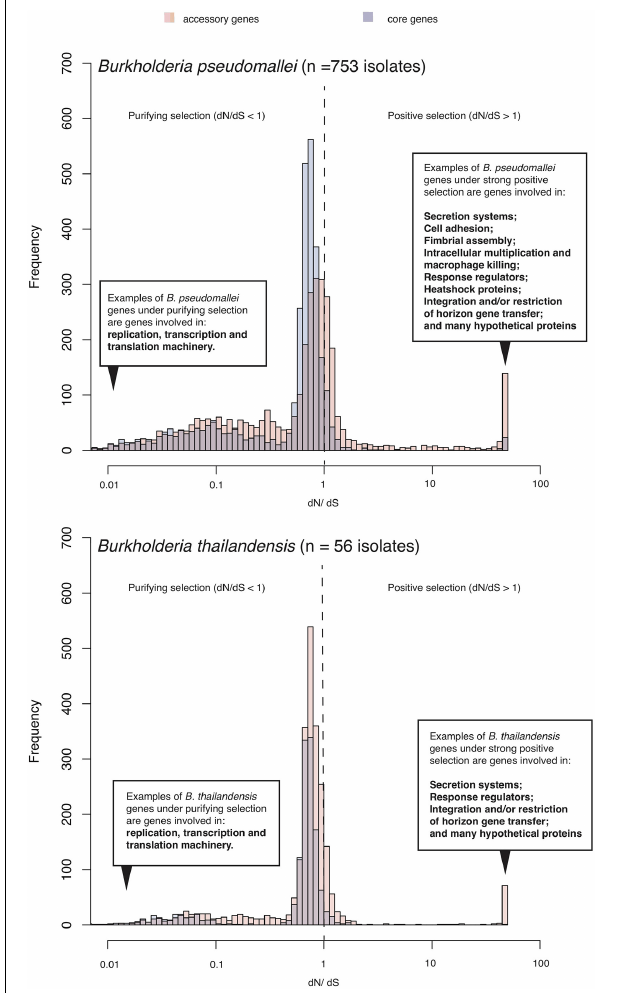
FIGURE 1 | Selection pressure acting on B. pseudomallei population. The histogram summarizes ranges of dN/dS calculated from predicted coding sequences from a collection of diverse B. pseudomallei population from northeast Thailand (Chewapreecha et al., 2019), and B. thailandensis genomes from the public database. B. pseudomallei and B. thailandensis have highly plastic genomes comprising of at least two chromosomes of ∼ 7–8Mb in size when combined. Using a pan-genome approach, all coding sequences could be categorized as “core” (present in all genomes) or “accessory” (variably present across studied genomes). Accessory genes display an elevated level of dN/dS which is signatures of positive selection or more relaxed purifying